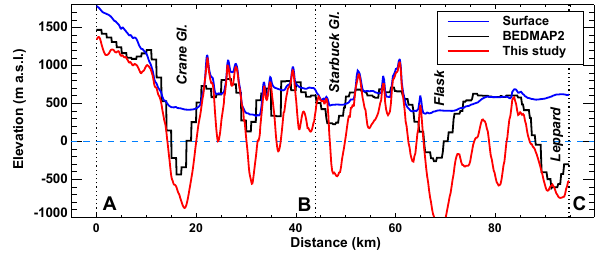
Figure 10. Comparison of bedrock elevation according to Bedmap2 and this study along the profile A–B–C (see Fig.